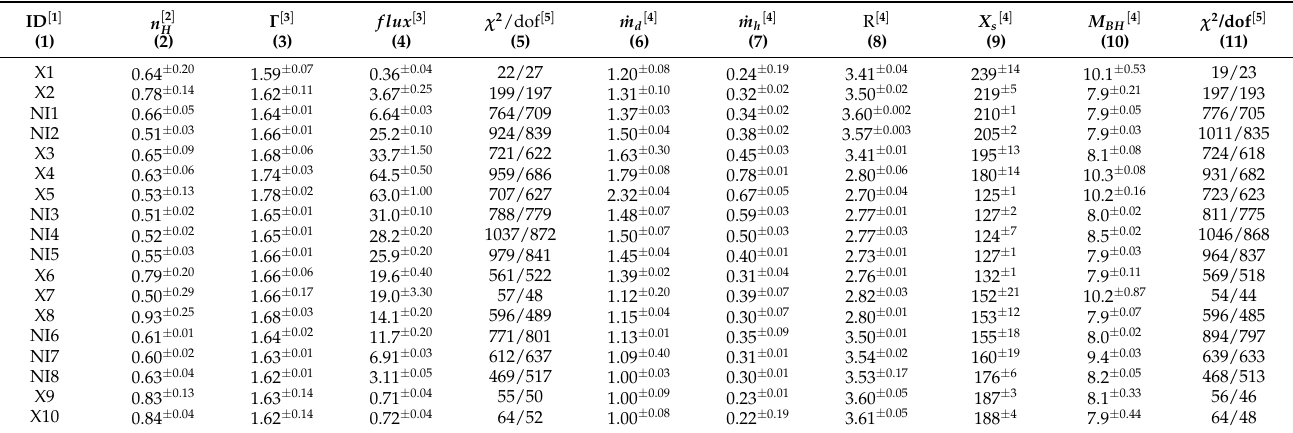
Table A1. Model-fitted parameters for Swift/XRT, combined NICER+MAXI/GSC and Swift/